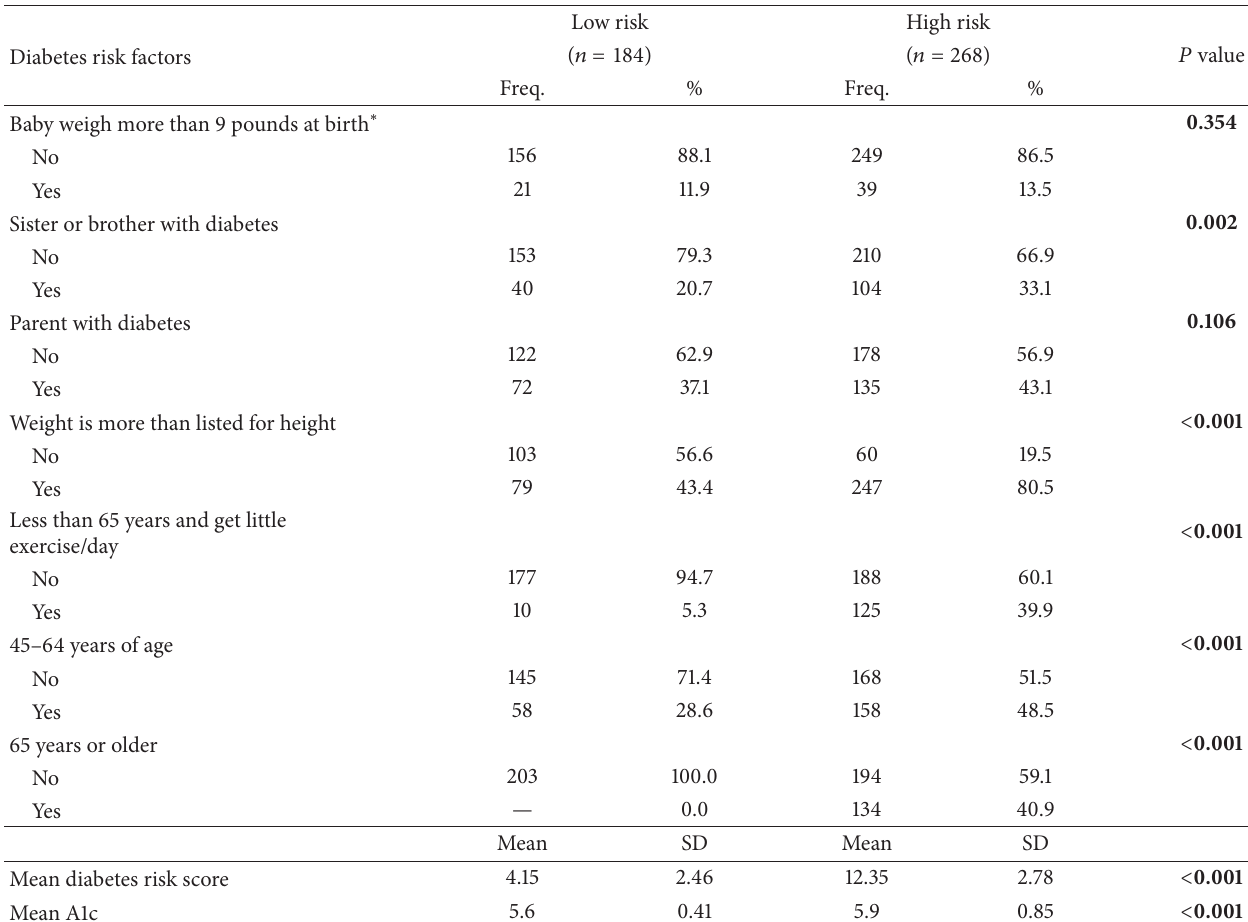
Table 2: Diabetes risk factors by low and high risk for prediabetes. Low